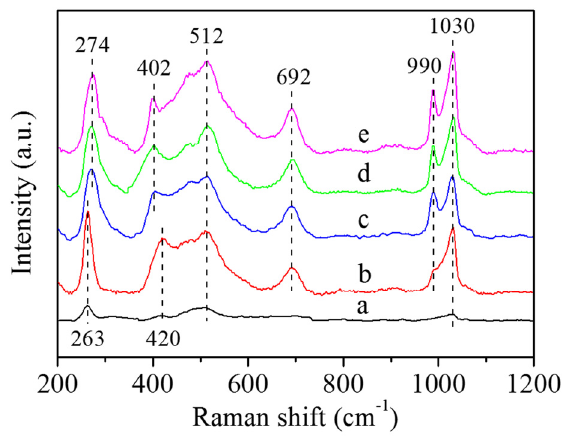
Figure 5. Raman spectra of V/SBA catalysts with different vanadium content. ( a ) 1% V/SBA; ( b ) 3% V/SBA; ( c ) 5% V/SBA; ( d ) 7% V/SBA; ( e ) 11% V/SBA.